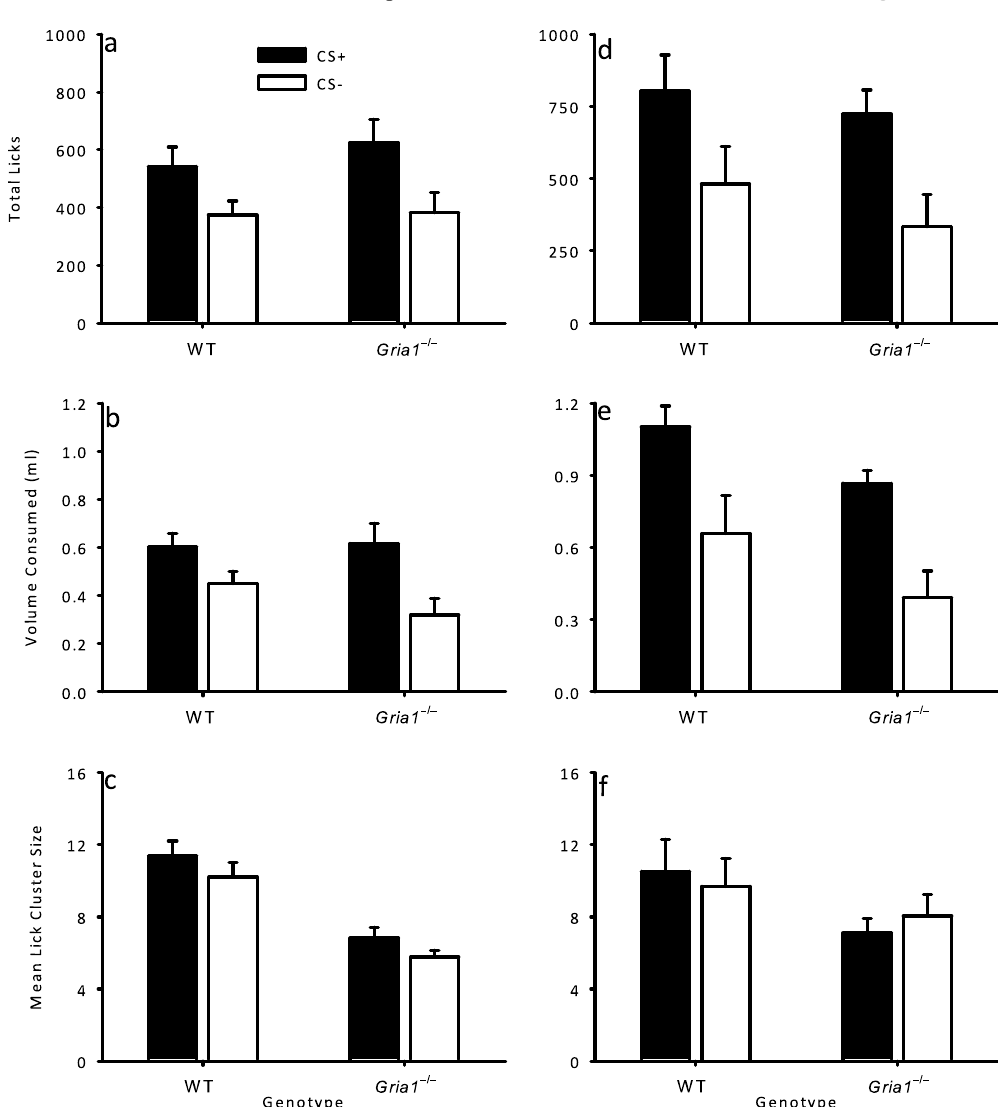
Figure 5. Flavour conditioning as a consequence of limited (one session) and extended (eight sessions) training. Measures of responding to the CS + flavour and the CS − flavour are shown by black and white bars respectively. The measures of licking behaviour for limited training (Experiment 4) are shown in the left column and those for extended training (Experiment 5) are shown on the right. Panels ( a ) and ( d ) show total licks, ( b ) and ( e ) show volume consumed (ml), and ( c ) and ( f ) show mean lick cluster size. Error bars indicate